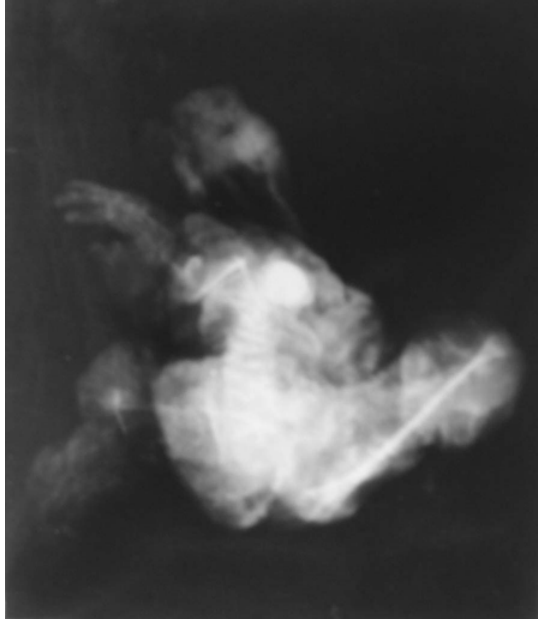
FIGURE 5. X ray of the specimen (fetus-in-fetu) showing vertebral column, ill formed base of the skull and limbs including a large